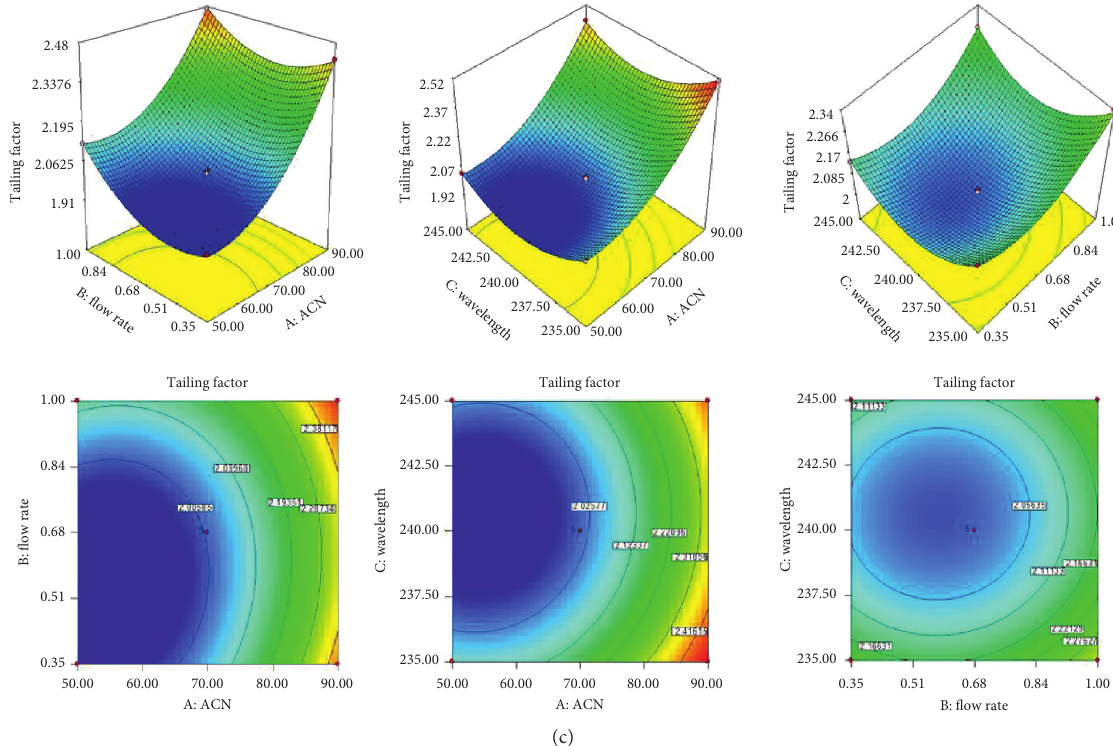
Figure 2: (a) Effect of acetonitrile, flow rate, and wavelength on the area. (b) Effect of acetonitrile, flow rate, and wavelength on the retention time. (c) Effect of acetonitrile, flow rate, and wavelength on the tailing factor.